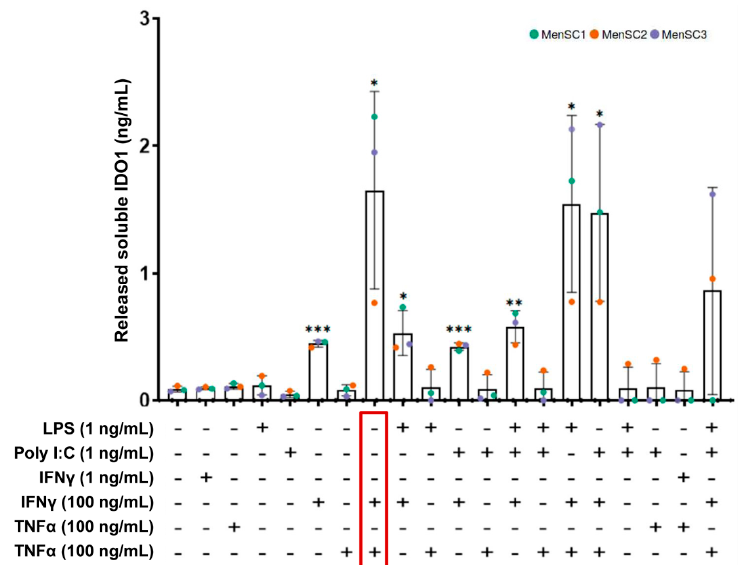
Figure 1. Release of soluble IDO1 by primed MenSCs. The MenSCs ( n = 3) were primed with several combinations and concentrations of pro-inflammatory cytokines (IFN γ and TNF α ) and the TLR ligands (LPS and Poly (I:C)). Levels of released IDO1 by the cells were tested by ELISA. A paired t -test was used to compare IDO1 levels in the basal MenSCs against different priming con- ditions. Colors refer to primary cultures from different donors. Error bars represent the standard deviations of data. Asterisks indicate statistically significant differences compared with the basal condition. * p < 0.05. ** p < 0.01. *** p < 0.001.